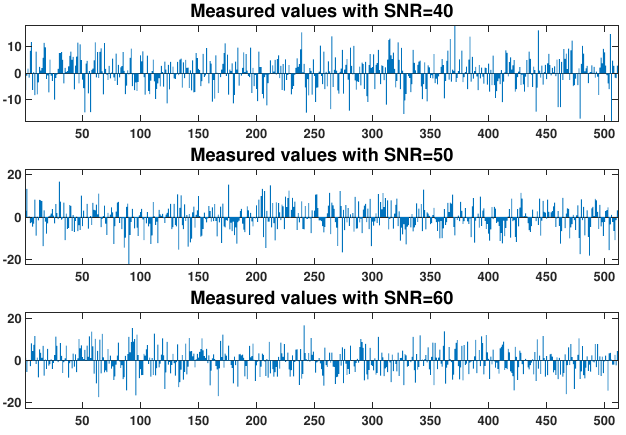
Figure 3. Measured values with SNR = 40, 50, 60, respectively. The results of the Algorithm 6 with ( N = 1 ) by inputting A i , i = 1, 2, 3 for